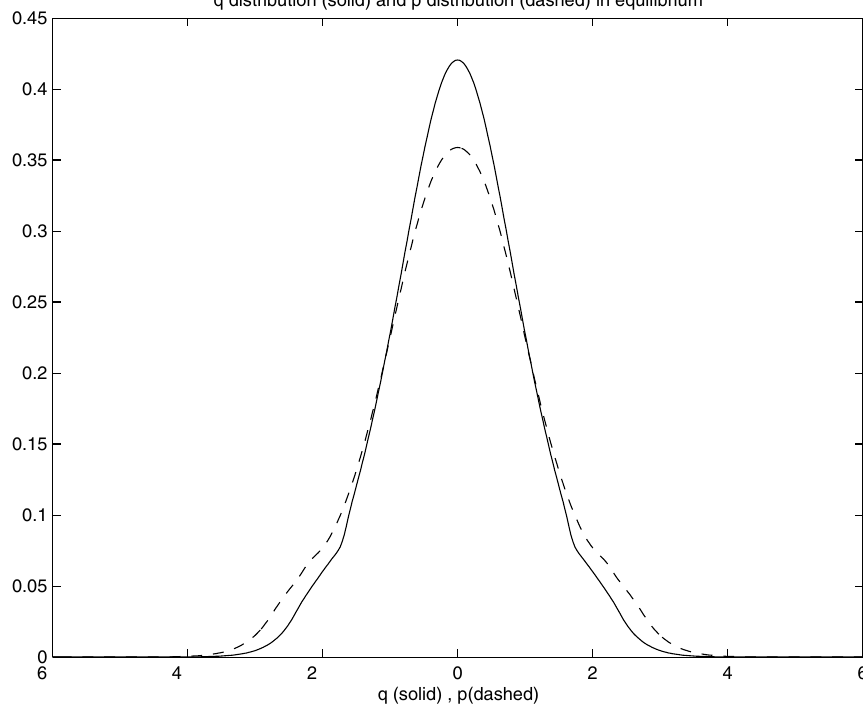
FIG. 4. R f (cid:1) q; p (cid:2) dp (solid line) and R f (cid:1) q; p (cid:2) dq (dashed line) in the equilibrium